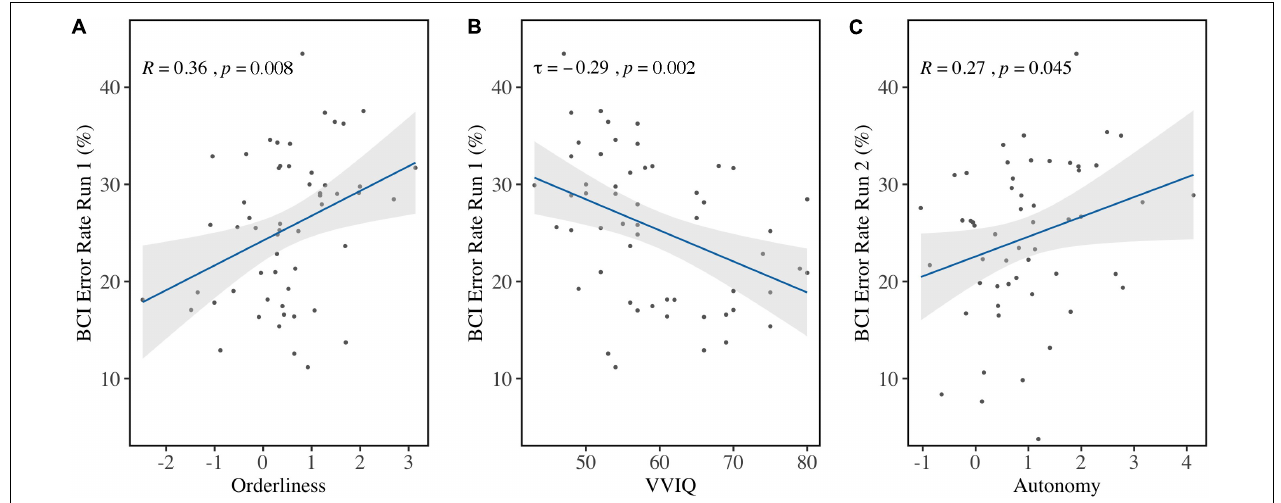
FIGURE 6 | Correlations between BCI Error Rates and individual factors. (A) BCI Error Rates in Run 1 were in significant positive correlation with Orderliness and (B) in significant negative correlation with VVIQ scores. (C) BCI Error Rates in Run 2 were significantly positively correlated with Autonomy before correction for multiple